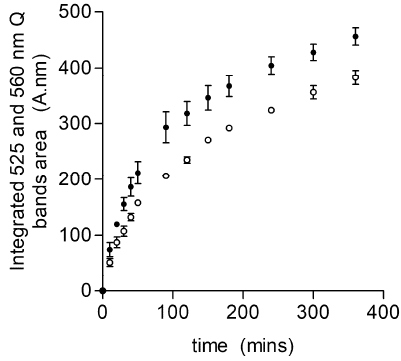
Figure 6. Comparison of HmuY-Fe(III)heme complex formation from hemoglobin. Glycated (close circles) and un-glycated (open circles) hemoglobin (64 µM with respect to monomer) samples were incubated with an equimolar concentration of HmuY. The combined integrated areas of 525 and 560 nm Q bands (from difference spectra) were used as a measure of HmuY-Fe(III)heme complex formation. The data points are an average from three separate experiments (mean ± SD).